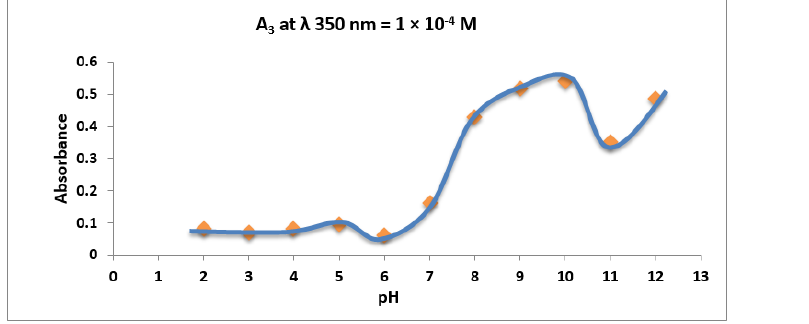
Fig. 10. Absorption curves - pH of base (A 3 ) at wavelength (350) nm